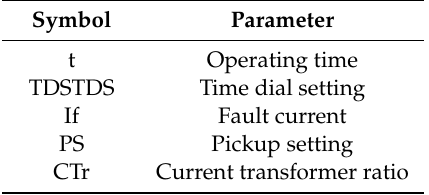
Table 1. Parameters of overcurrent protection function.